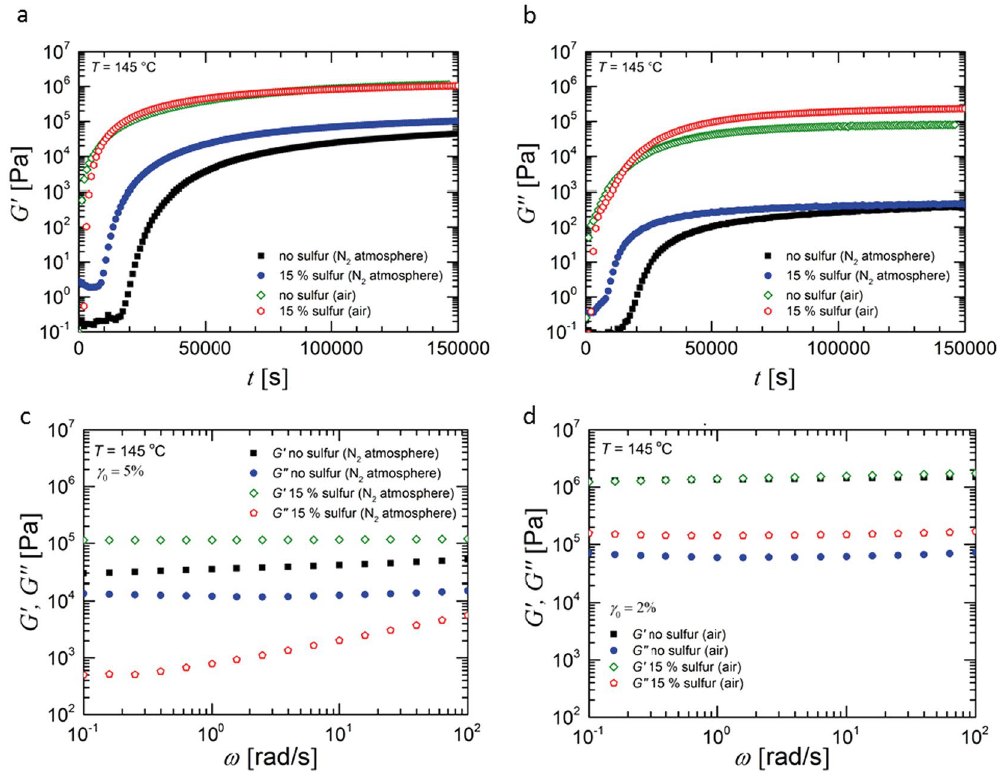
Figure 3. ( a ) Storage modulus G ′ and ( b ) loss modulus G ″ of α , ω -polybutadiene dicarboxylic acid as a function of time t during the thermal treatment at 145 °C. The time-dependent increase of the moduli indicates an oxygen induced polymerization and an oxygen supported vulcanization of α , ω -polybutadiene dicarboxylic acid. The angular frequency was ω = 0.1 rad ∙ s − 1 and the shear amplitude γ 0 = 5%. The storage modulus G ′ increases most rapidly for the crosslinking reactions in air. Results of frequency sweep experiments after the vulcanization reaction of α , ω -polybutadiene dicarboxylic acid in ( c ) a nitrogen atmosphere and ( d ) an air atmosphere. The graphs present the dynamic moduli G ′ and G ″ as a function of angular frequency ω